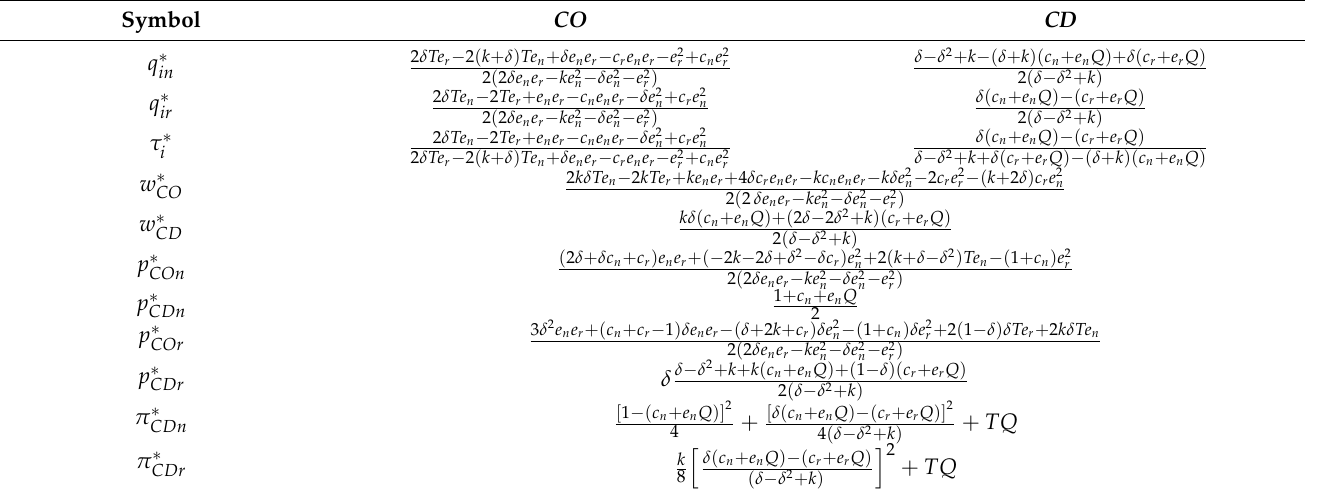
Table 2. The optimal solutions under both